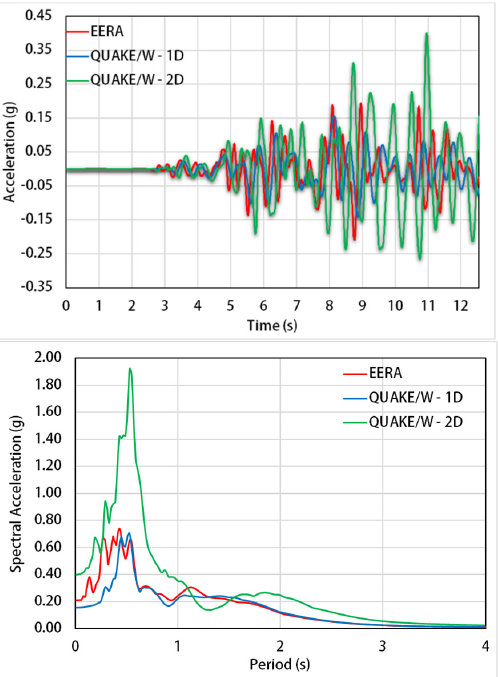
Figure 18. Comparison between 1-D and 2-D analyses performed by EERA and QUAKE/W for point 2 in terms of acceleration time history and spectral acceleration, for the Amoruso et al. [26] input.